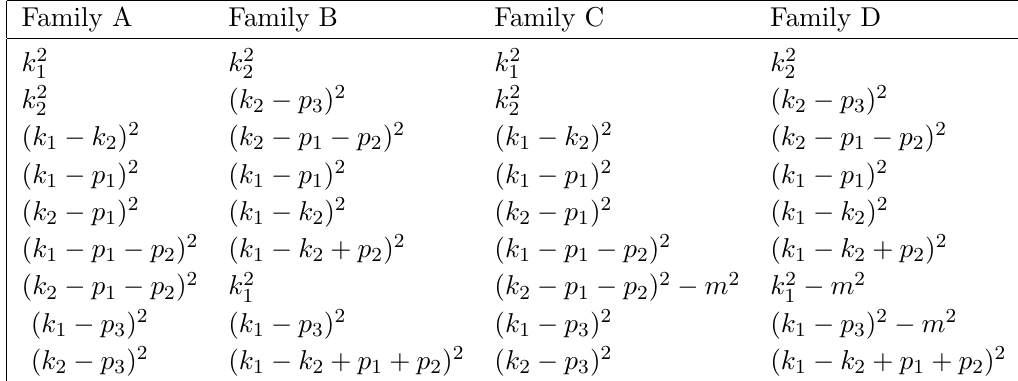
The four integral families used for the two-loop mixed EW-QCD Drell-Yan master integrals with either no massive internal lines or exactly one massive internal